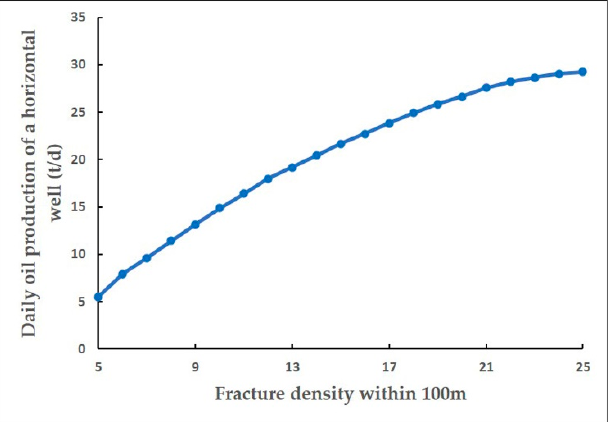
Figure 13. The influence of fracture density within 100 m on horizontal well production.